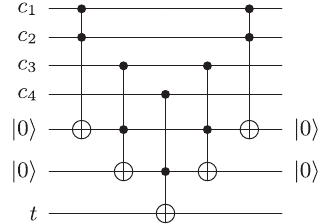
FIG. 3. Making a C 4 X gate with controls c 1 , c 2 , c 3 , c 4 and target t from five Toffoli gates and two